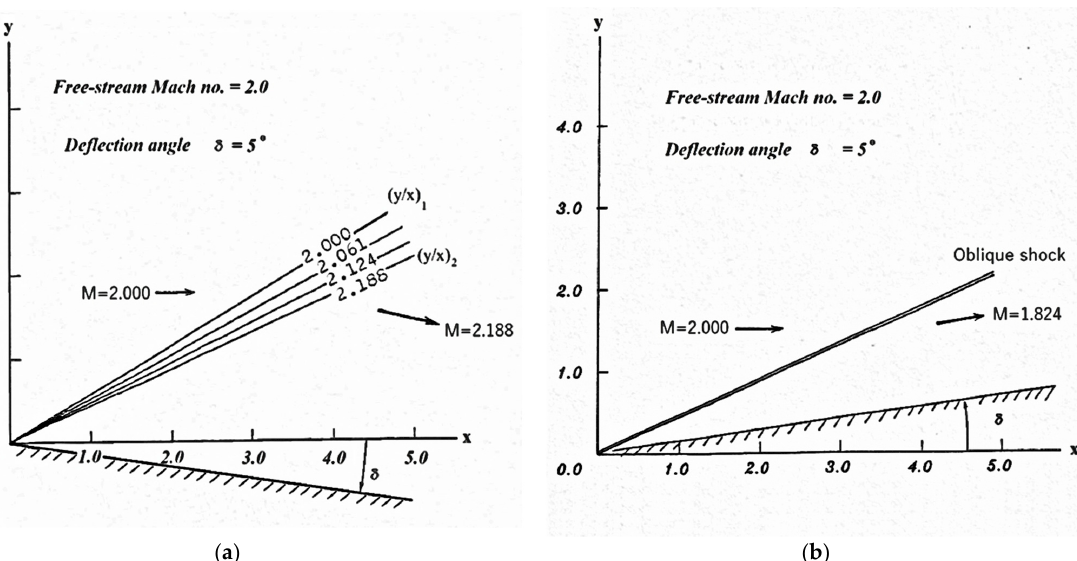
( d ) Figure 2. Examples of supersonic far field flows: ( a ) Iso-Mach lines of Prandtl–Meyer (expansion fan) flow, ( b ) oblique shock of a concave corner flow, ( c ) iso-Mach lines and shock waves of a dou- ble-wedge airfoil with δ = 0.15 and M (cid:2998) = 2 .0, and ( d ) iso-Mach lines and shock waves of a parabolic airfoil with δ = 0.06 and M (cid:2998) = 1.6. When comparing Equations (67) and (71), we found that the position of the first Mach line (freestream) was after the last Mach line (downstream). The flow field during these two Mach lines exists in a “multi-valued” region [3]. For ensuring the solution’s unique- ness in this case, we need to use the jump condition in Equation (47) to identify the shock wave position: (cid:4672) (cid:2914)  (cid:2914)  (cid:4673) (cid:2929)(cid:2918)(cid:2925)(cid:2913)(cid:2921) =  (  (cid:2878)(cid:2869))(cid:2897) (cid:3246)(cid:3120) (cid:2872)(cid:2886) (cid:3118)